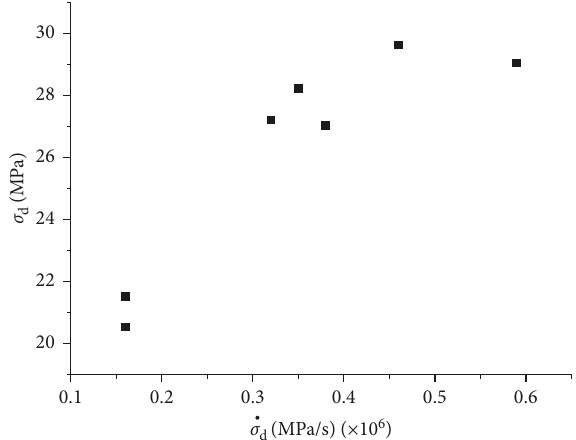
Figure 12: Relationship between dynamic tension strength and loading rate at depth